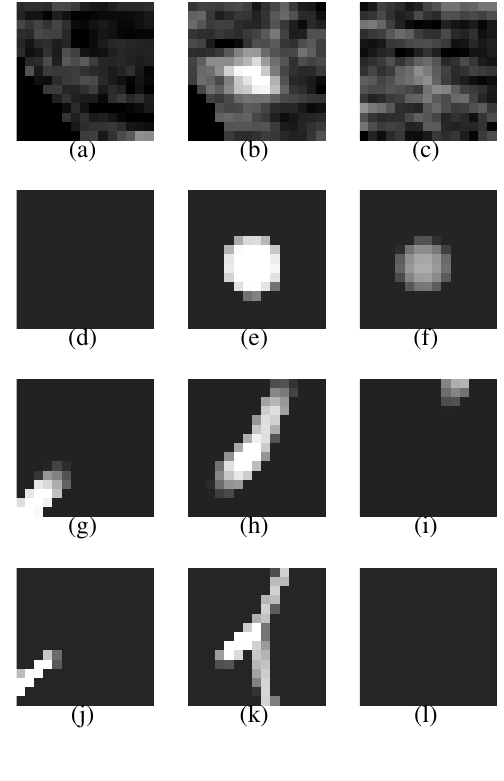
Figure 10. A VOI of the nodule shown in Figure 9 and its